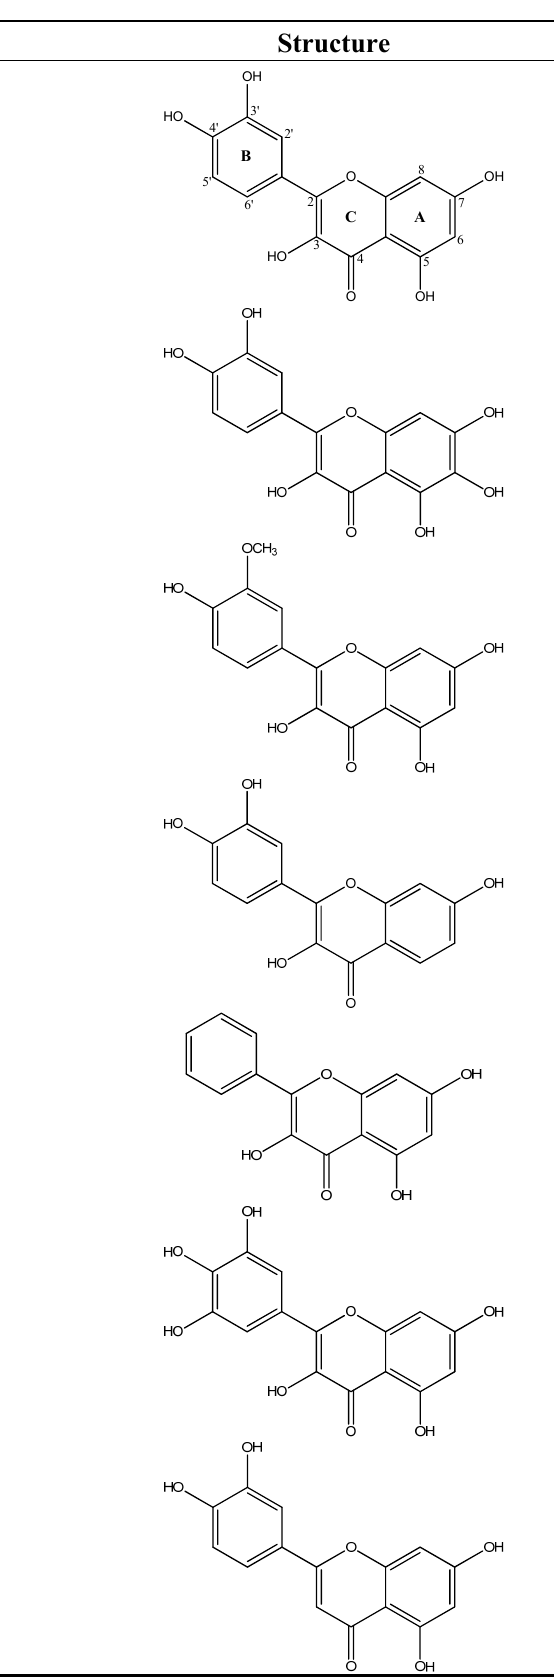
Table 1. Structures of the studied